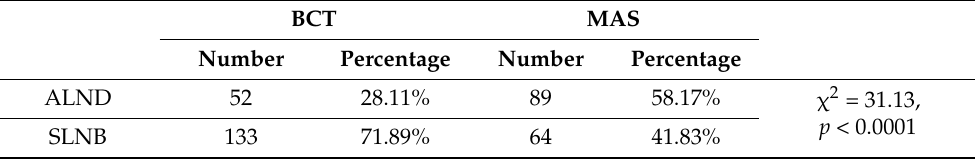
Table 2. Type of procedure performed within the regional lymph system depending on the type of breast cancer